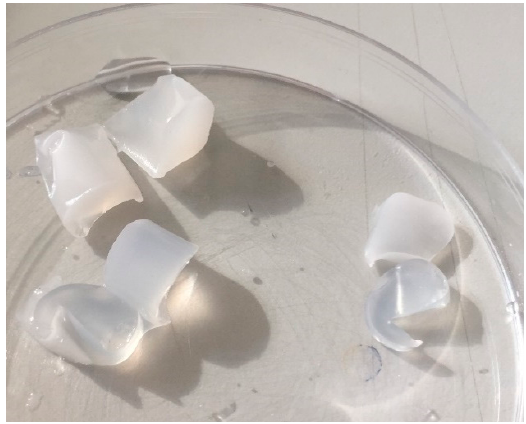
Figure 7. Picture of the potato starch hydrogels obtained in this investigation at fixed conditions (starch-water concentration of 20% w/w, mean size of < 25 µm and processed at 600 MPa for 15 min at 50 °C).